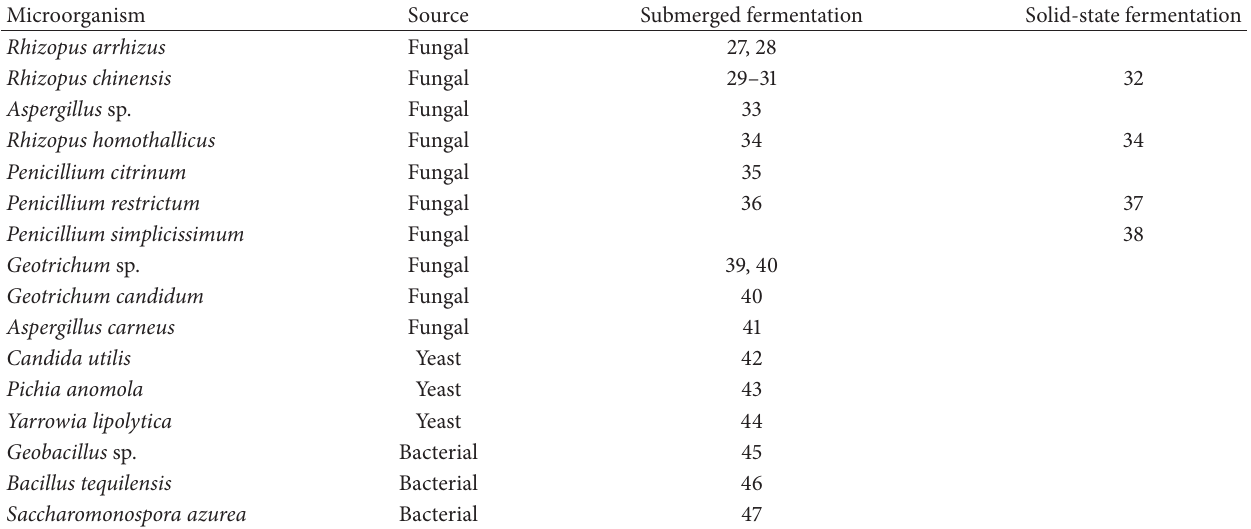
Table 1: Microorganisms cited in the recent literature as potential lipase